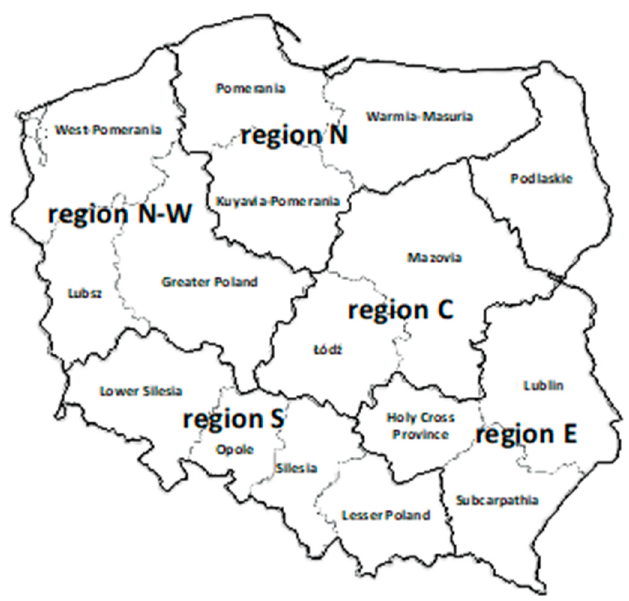
Figure 1. Examined geographical regions of Poland according to the Chief Statistical Office with modification, including the concentration of cows per 100 ha of the agricultural area.